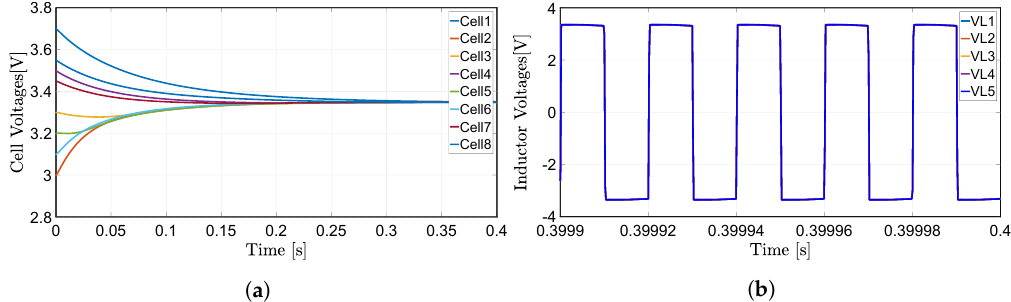
Figure 12. ( a ) Cell voltages of the proposed eight-cell ´cuk balancing circuit; and ( b ) inductor voltages of the proposed ´cuk balancing circuit with eight cells in